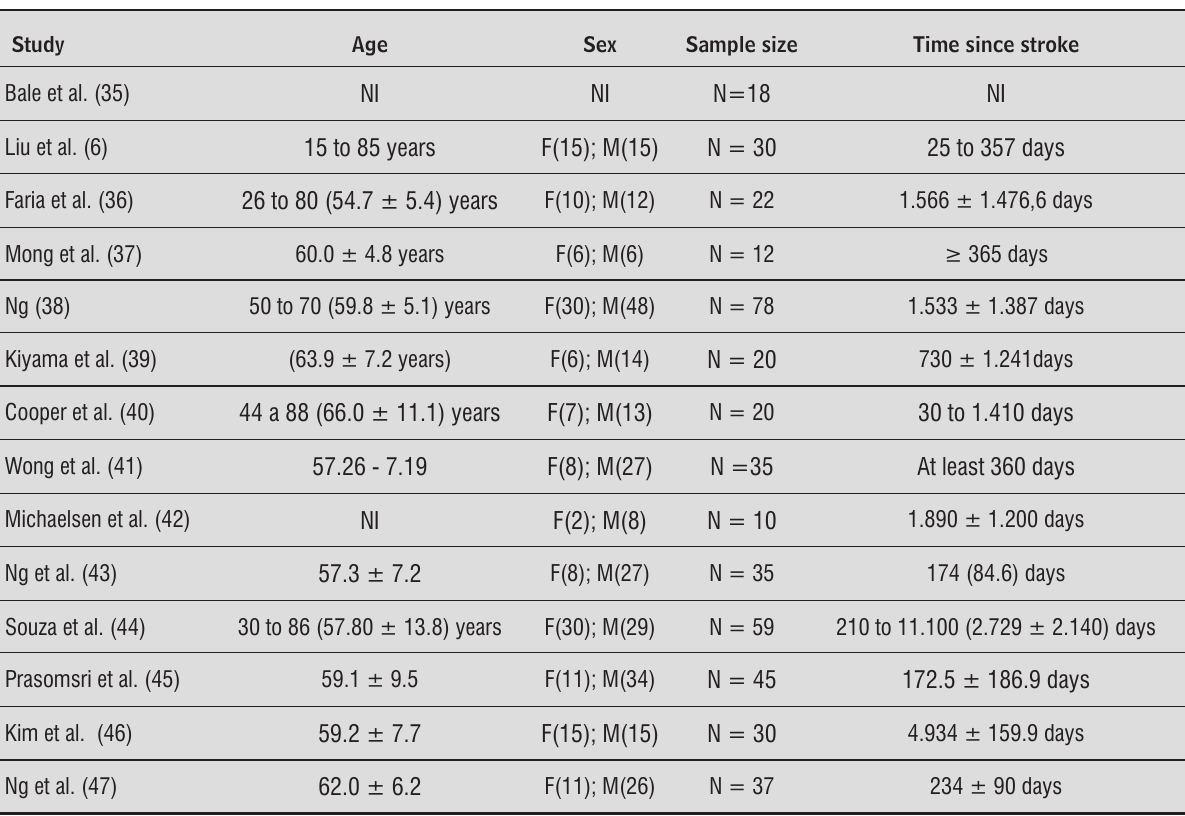
Table 1 - Clinical and demographic characteristics of the participants included in the 30 studies that assessed the strength of the lower limb muscles with portable dynamometry in subjects with stroke